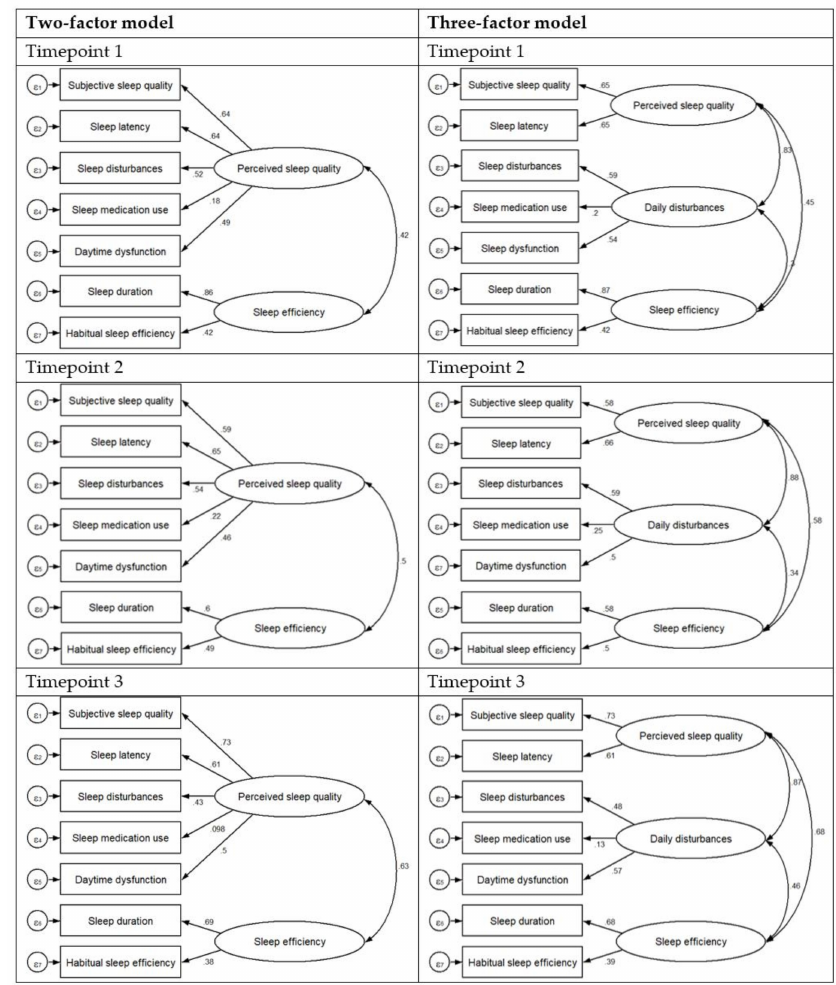
Figure 1. Factor loadings for the two and three-factor models at each